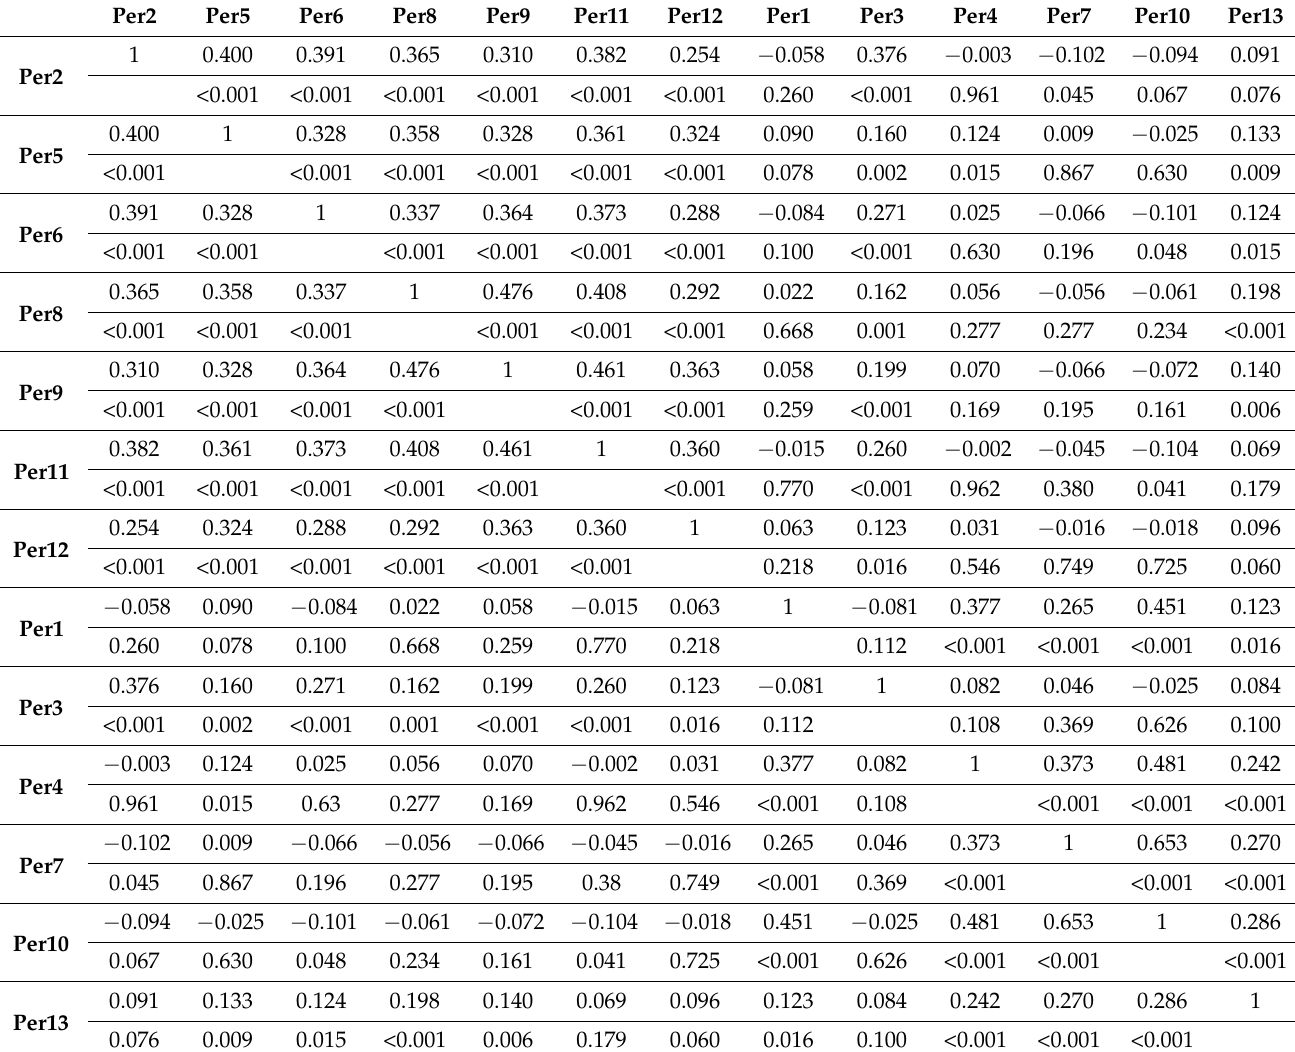
Table 3. Pearson correlation among items of Motivational Persistence